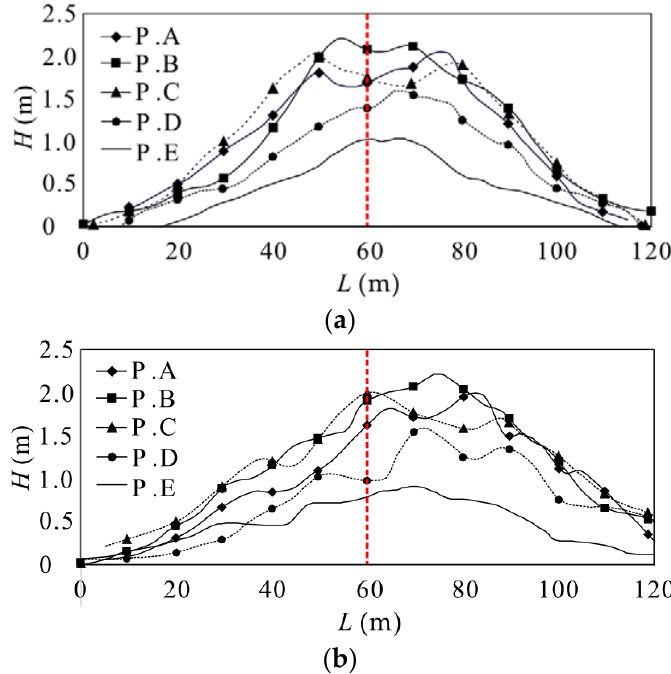
Figure 11. The cross ‐ sectional profile along ( a ) horizontal direction and ( b ) longitudinal direction.